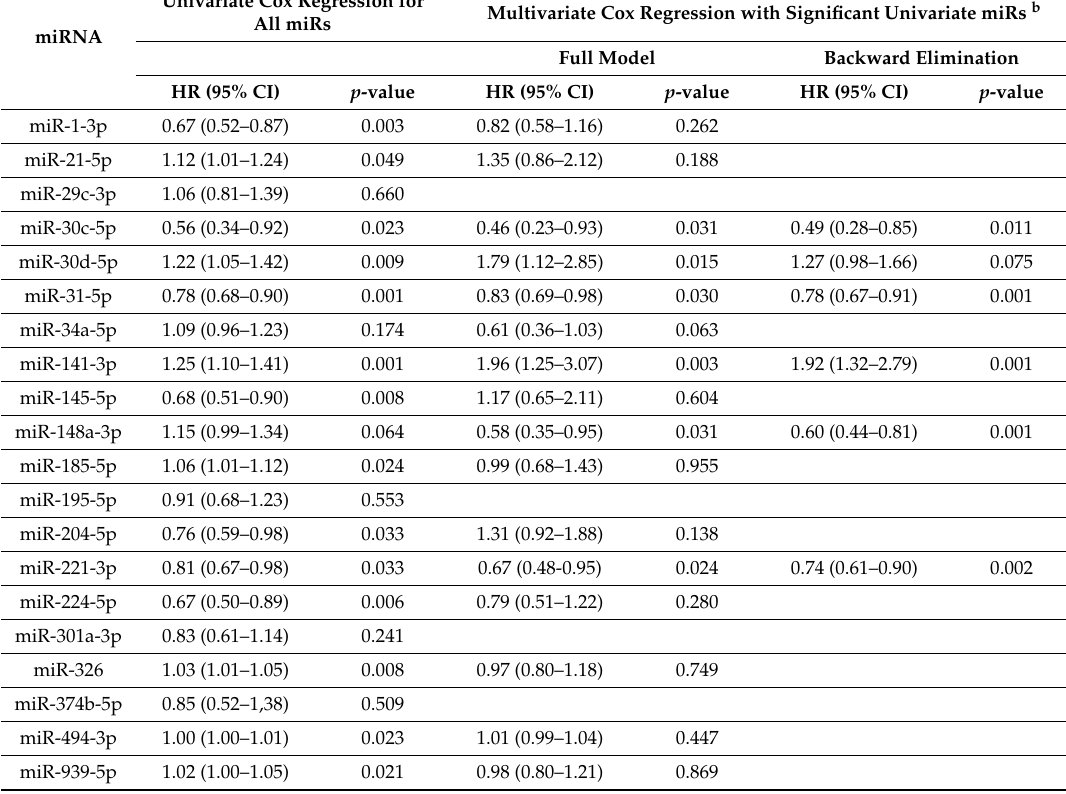
Table 4. Construction of a miRNA-based predictive classifier for biochemical recurrence, using a bootstrapping approach of Cox regression analysis with all 206 tumor samples. a Univariate Cox Regression for All miRNA